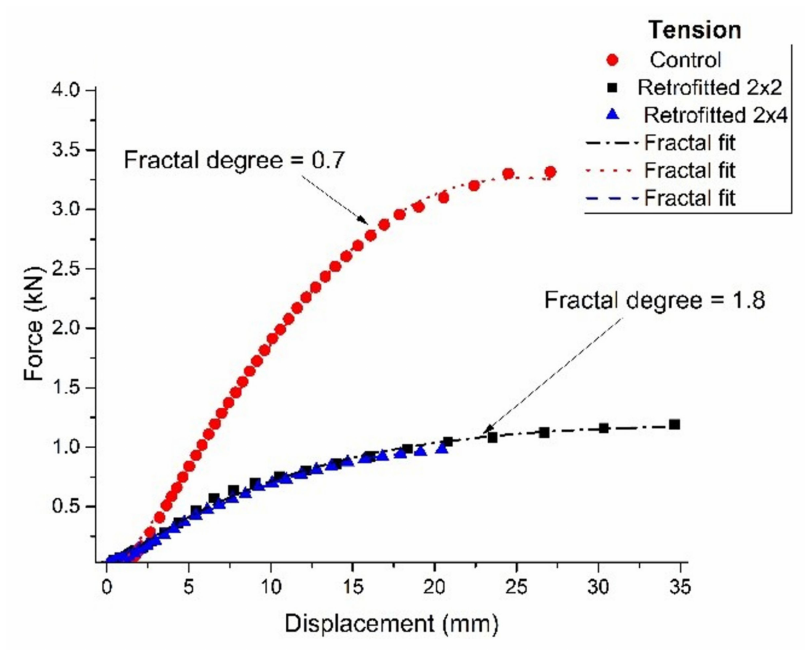
Figure 11. Behavior of samples rehabilitated with “liquid wood”, subjected to